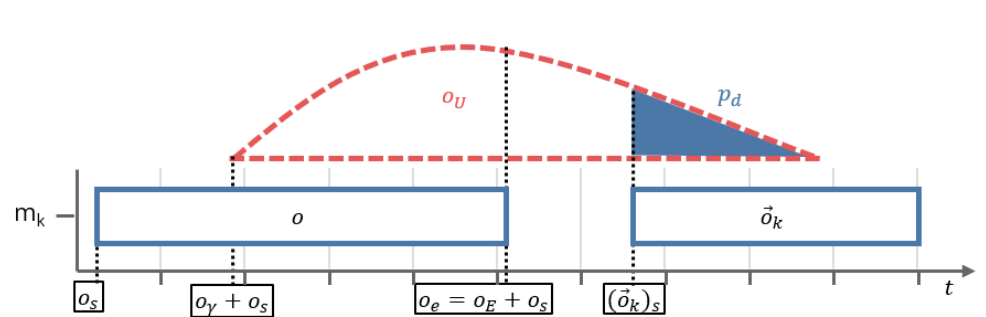
Figure 3. Two subsequent operations on a machine m k . With a probability of p d , the machine −→ o k is shifted to the right on the time axis. Expected shift: E d . predecessor operation